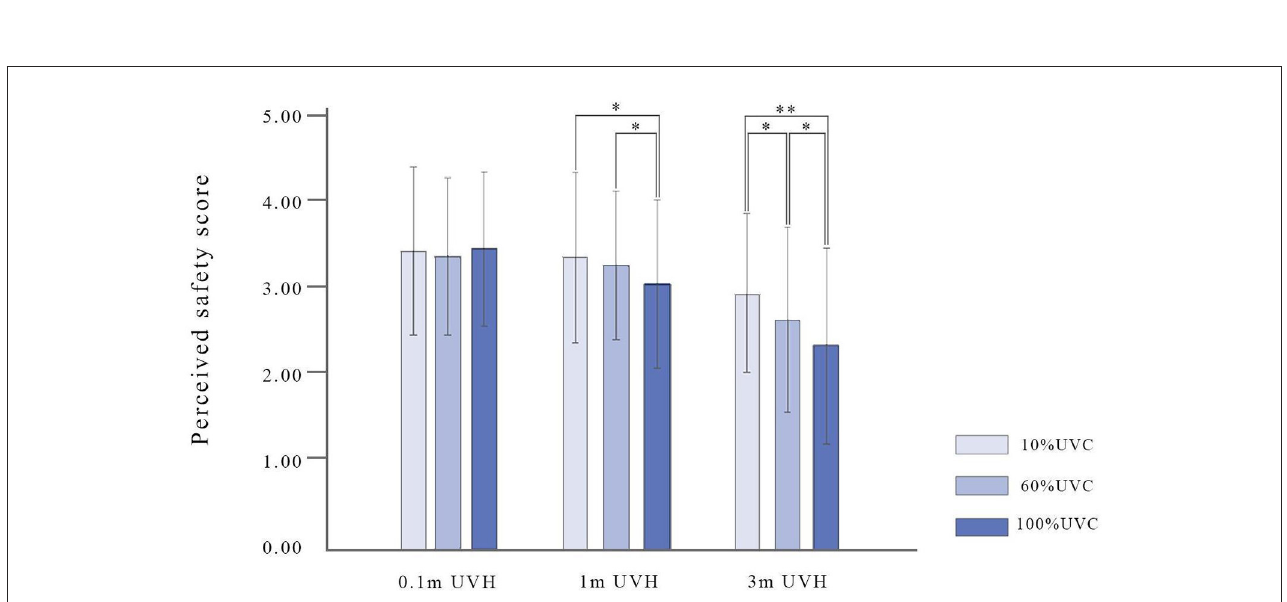
FIGURE11 The interaction of UVC and UVH on perceived safety. UVC, understory vegetation cover; UVH, understory vegetation height. * p < 0.05; ** p < 0.01.